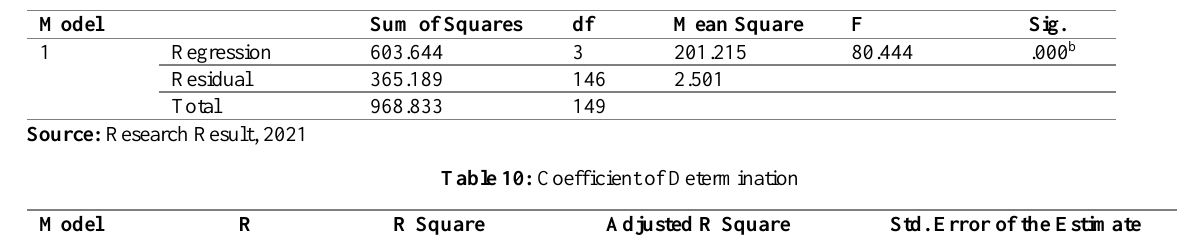
Table 9: Result of F Test